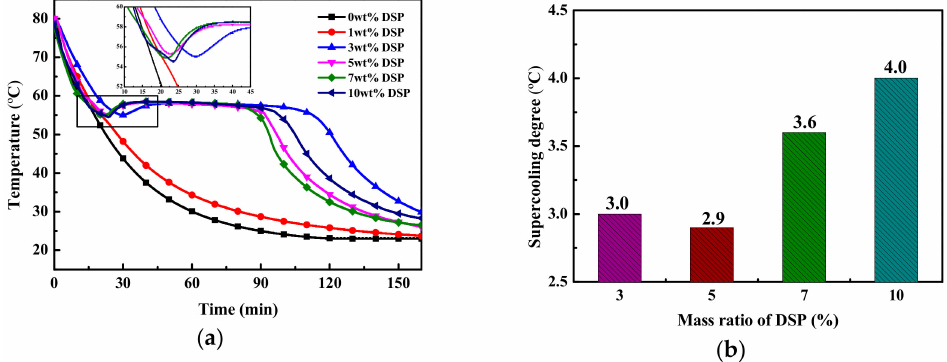
Figure 2. ( a ) Cooling curves and ( b ) supercooling degrees of SAT modified by di ff erent contents of